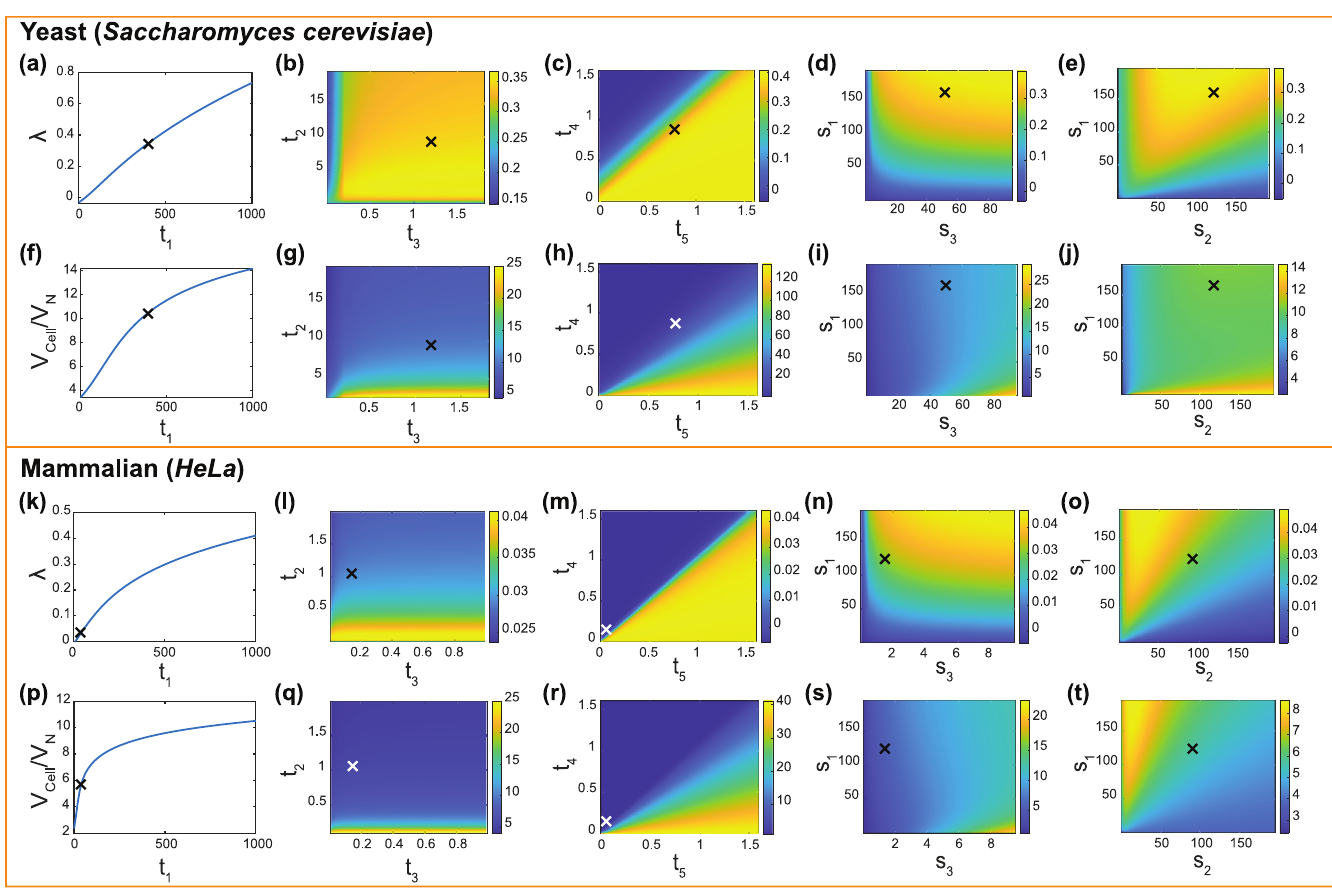
Fig 4. Effects of synthesis and transport parameters on the cell growth rate and the C/N ratio. (a)-(c) Effects of amino acid import ( t 1 ), ribosomal protein transport ( t 2 ), ribosome transport ( t 3 ) and non-ribosomal protein transport ( t 4 and t 5 ) on growth rate. Notably, the growth rate is non-monotonically influenced by t 2 , and there’s a sharp change in growth rate around t 4 = t 5 . (d)-(e) Effects of non-ribosomal and ribosomal protein synthesis ( s 1 and s 2 ) and ribosome synthesis ( s 3 ) on growth rate. There is an optimal s 1 / s 2 for the maximum growth rate. (f)-(j) Effects of transport and synthesis on the C/N ratio. protein synthesis coefficients s 1 and s 2 have a non- monotonic influence on C/N ratio. (k)-(t) Corresponding results for mammalian cells. Interestingly, compared to yeast cell case, s 1 and s 2 have different effects on C/N ratio due to different ribosome synthesis coefficient s 3 . Realistic values are marked as “X”. All parameters except for the scanned parameters are listed in Table 2.